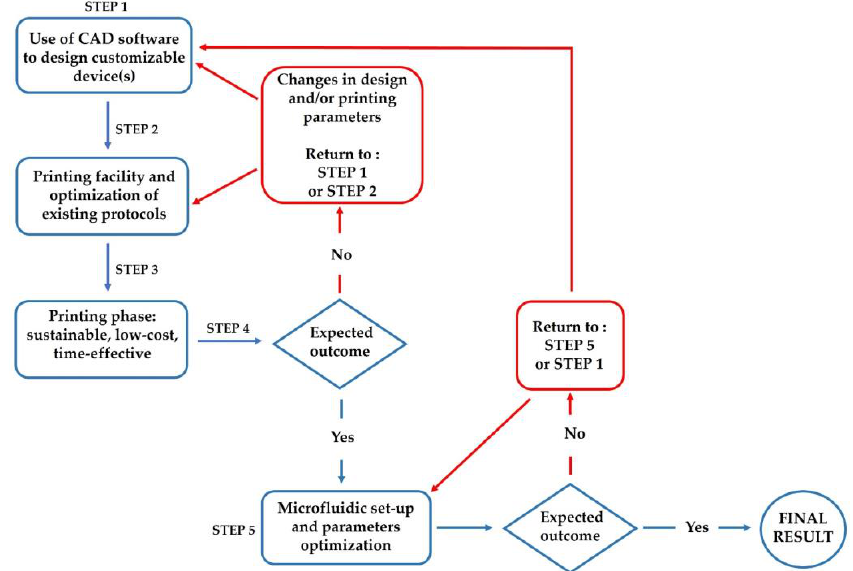
Figure 10. Schematic flowchart regarding the combination of 3DP and MF. The diagram is an